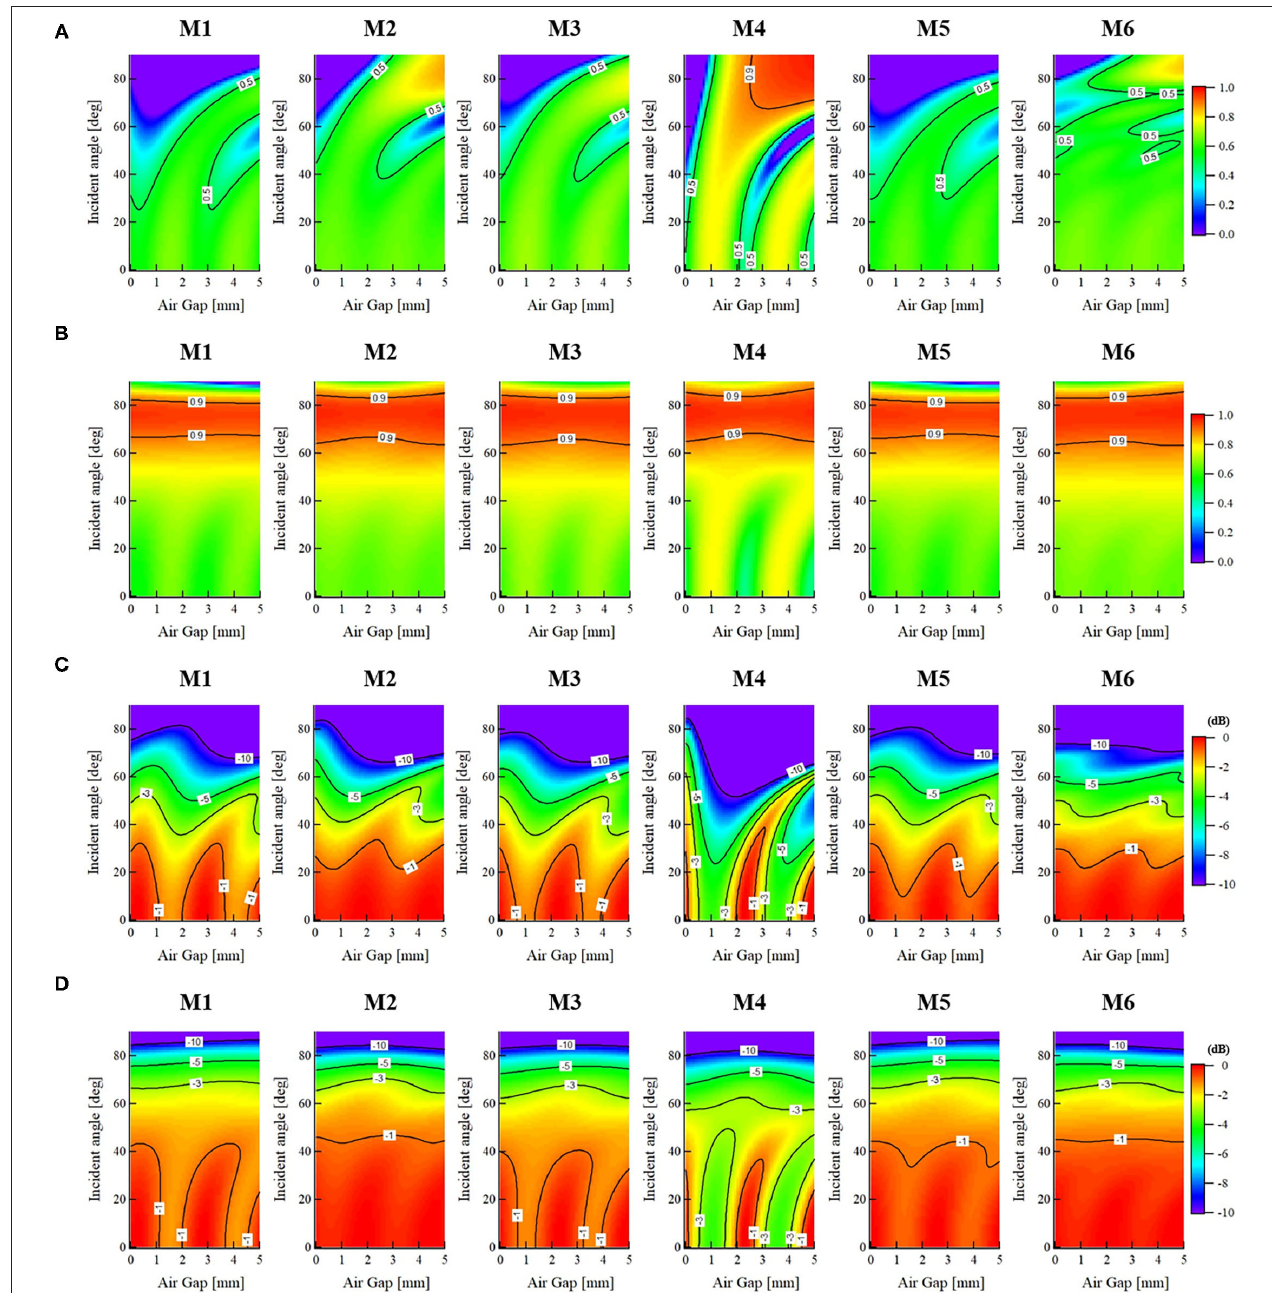
FIGURE 2 | Mean values of transmittance and absorbed power density at skin surface as functions of oblique incidence angles θ 0 and air gap spacing z air when the skin model is covered by various types of cloth materials at 60 GHz, (A) Transmittance (TE wave), (B) Transmittance (TM wave), (C) APD (TE wave), and (D) APD (TM